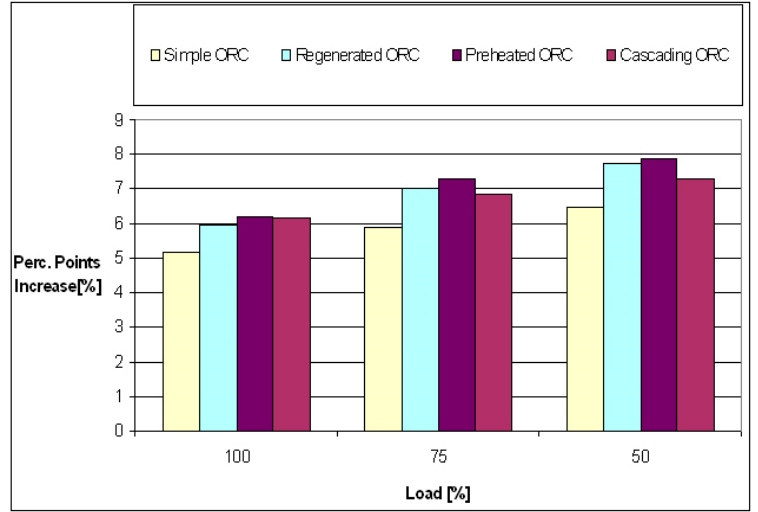
Figure 11. Increase in percentage points of the combined propulsion system efficiency, according to the load, for the different cycle configurations studied.